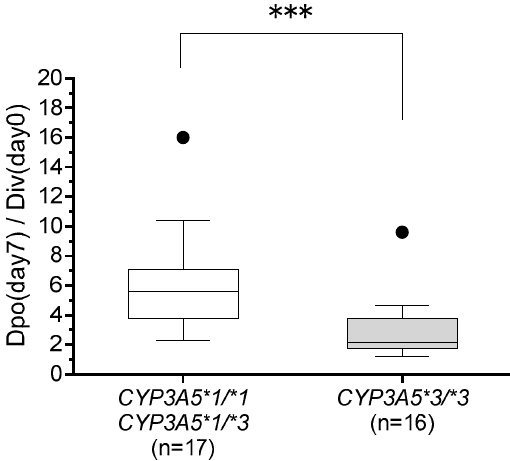
Figure 4. Comparison of tacrolimus dose ratio (Dpo(day7) / Div(day0)) between those with CYP3A5*1 / *1 or CYP3A5*1 / *3 genotypes ( n = 17) and those with CYP3A5*3 / *3 genotype ( n = 16). The dose ratio from just before the change from continuous intravenous infusion (Div(day0)) was compared with that from seven days after the change to oral administration (Dpo(day7)). The bars show the median values, and boxes represent the 25th and 75th percentiles of the data. *** p < 0.001.